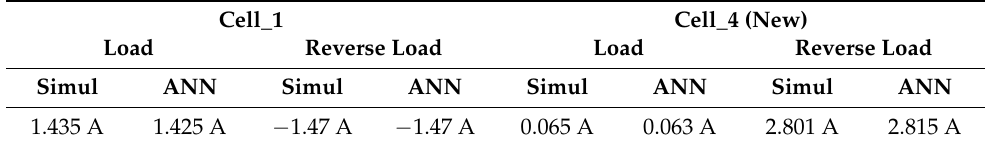
Table 8. Comparison of ANN model with simulation results.